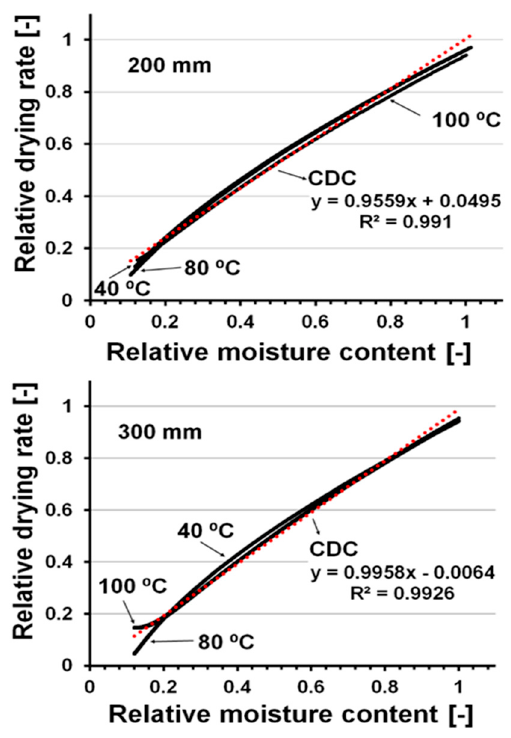
Figure 4. Characteristic drying curves for the bed heights of 200 mm and 300 mm. Air velocity 0.75 m / s in all cases. Mixture ratio 50% soot :50% sawdust .